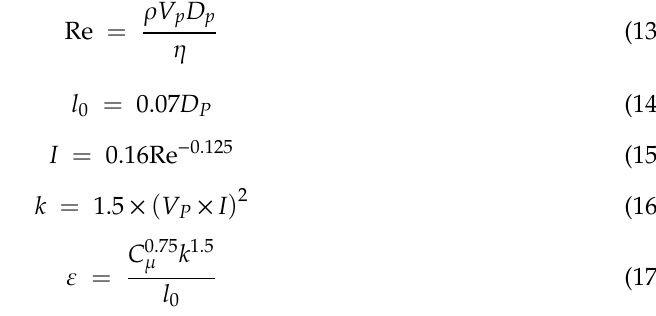
Table 1. The parameter values of the pipeline